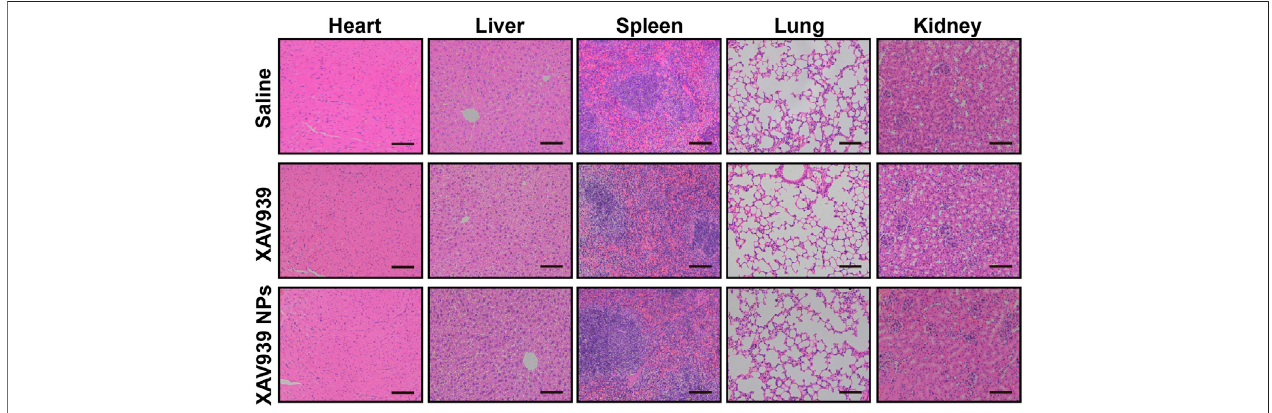
FIGURE 7 | Main visceral organs biosafety assessments in alkali-burned mice. Representative images of H&E staining of the heart, liver, spleen, lung, and kidney following 14 days treatment of saline, 10 μ M XAV939, and XAV939 NPs (10 μ M XAV939 equivalent). Scale bar: 200 μ m.